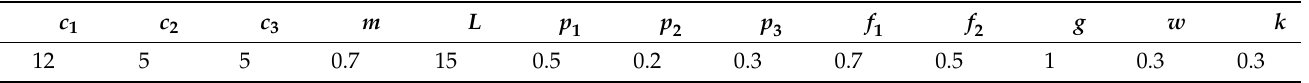
Table 5. Parameter